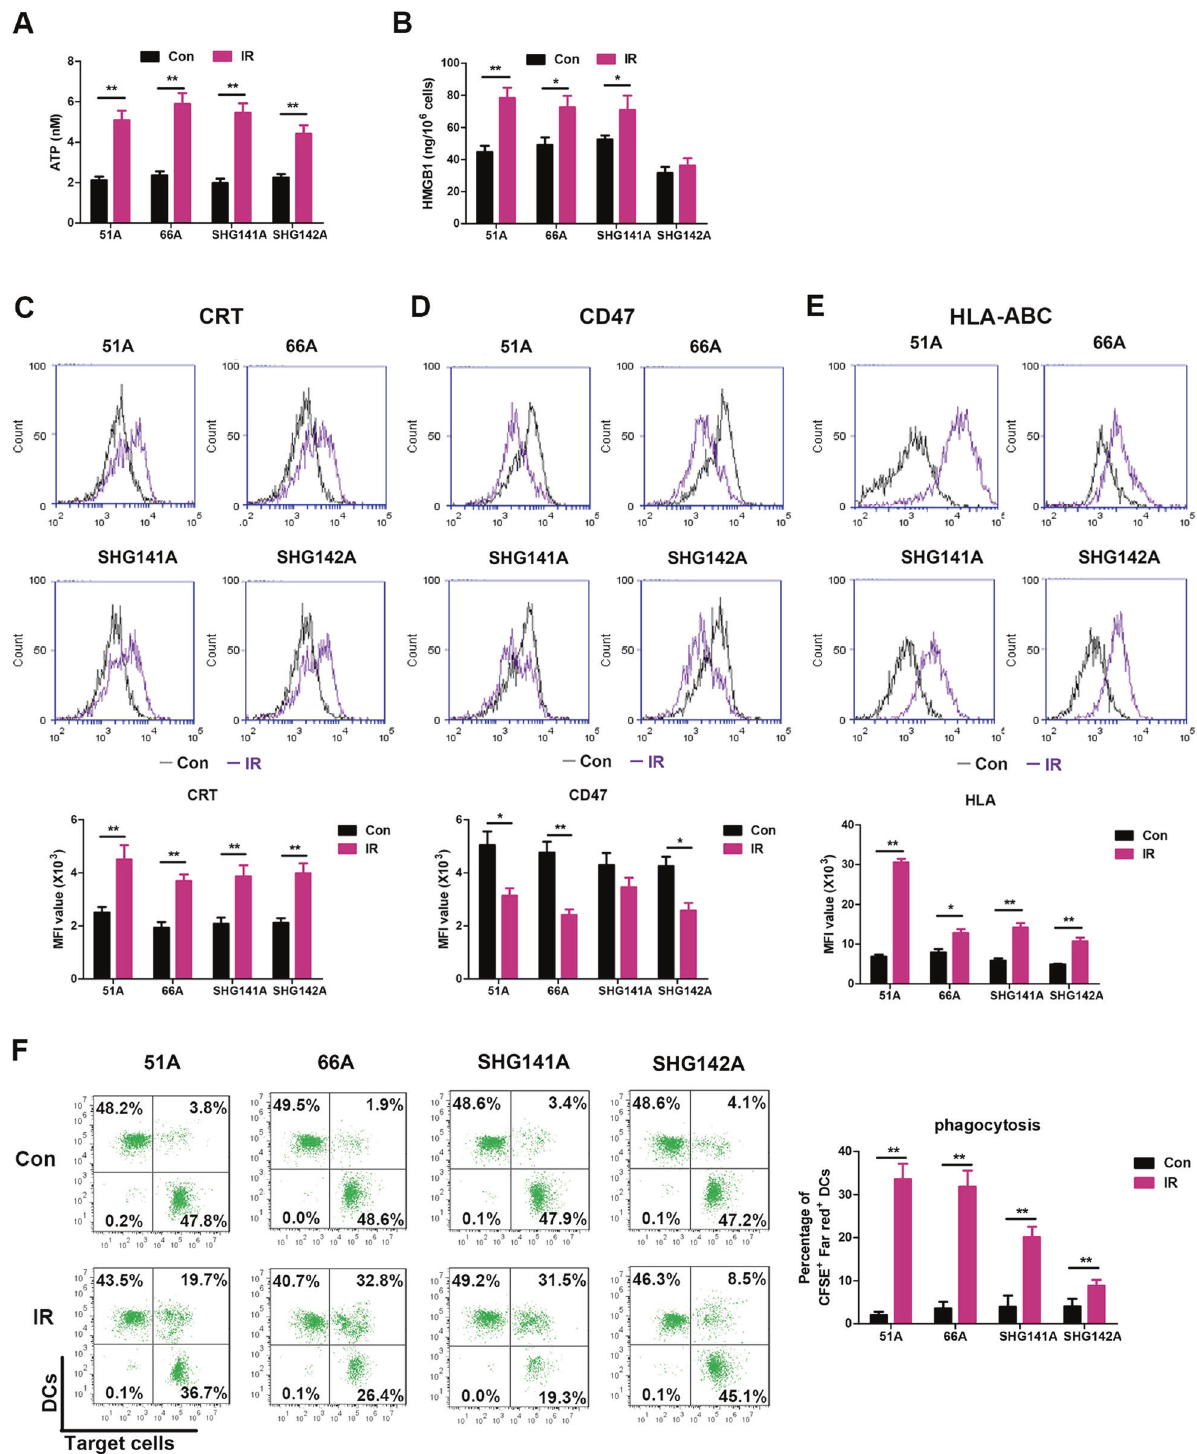
Fig. 1 High-dose IR triggers ICD in GSCs. A – E GSCs were irradiated with dose of 10 Gy, then ICD hallmarks were analyzed 24 h post-IR. A Supernatants were collected, and the amount of eATP release was measured by luciferase-based test. B Released HMGB1 level was assessed by an ELISA assay in cultured supernatants. The surface exposure of CRT expression ( C ), CD47 expression ( D ), and HLA-ABC expression ( E ) on cell surface were determined by fl ow cytometry, and mean fl uorescence index (MFI) was quanti fi ed. F Untreated or irradiated GSCs were co- cultured with DCs for 24 hours at a 1:1 ratio, and the percentage of DCs phagocytosis was assessed by fl ow cytometry. Data represent the mean ± SEM of triplicates and are representative of at least three independent experiments or are plotted as individual points. * P < 0.05, ** P < 0.01 vs